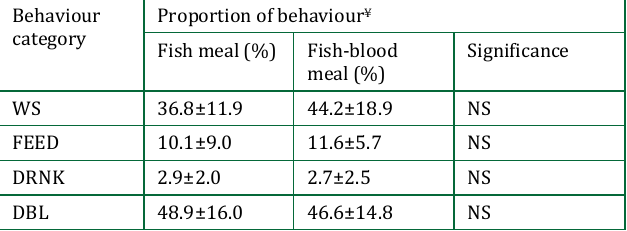
Table 2: Comparison between feed type and behaviour (T-test, n=30) Behaviour category